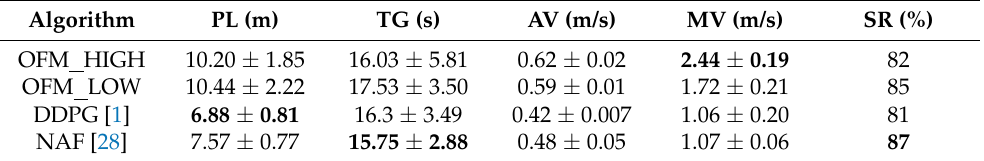
Table 2. Comparison of the proposed collision-avoidance algorithm with a state-of-the-art learning- based method. A set of 100 experiments were conducted for each algorithm. OFM HIGH, OFM LOW mean Only Forward Maneuver with high velocity, Only Forward Maneuver with low velocity, respectively. PL, TG, AV, MV, SR depict path length, time to goal, average velocity, maximum velocity, and success rate, respectively. In the Table, the bold number means the best performance of one parameter.